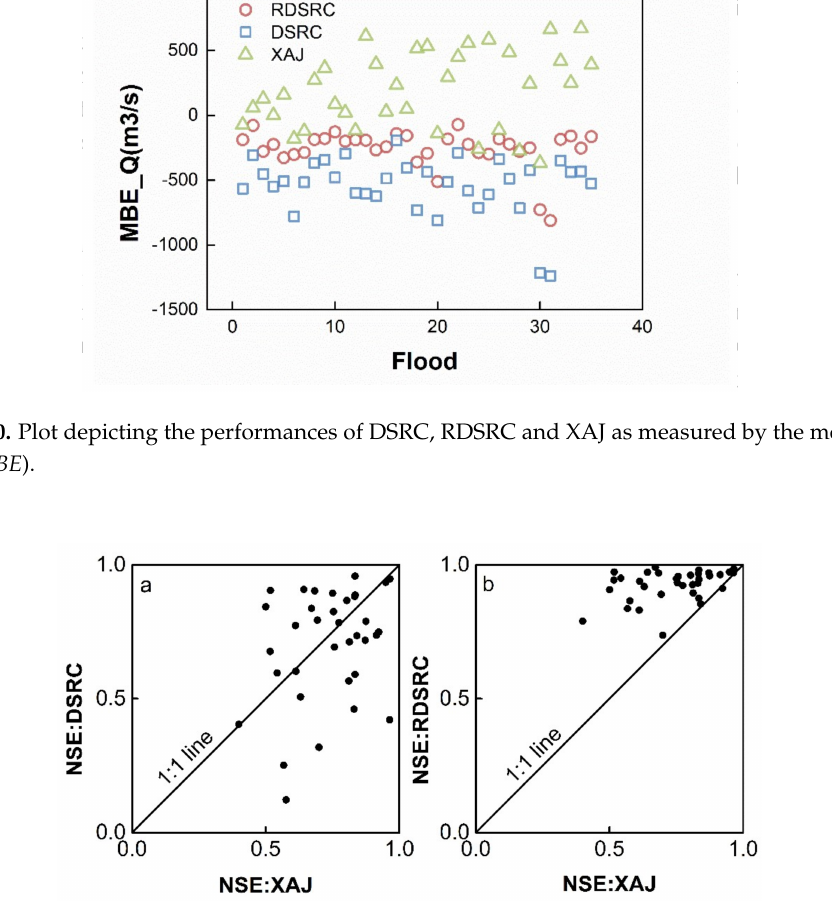
Figure 11. Plot depicting the performances of DSRC, RDSRC and XAJ as measured by NSE